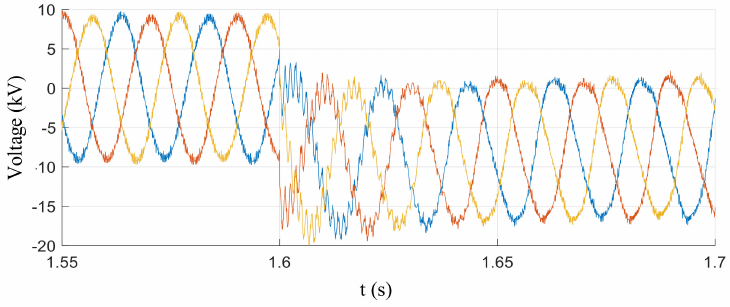
Figure 17. Relative ground voltage waveform of the 10 kV AC